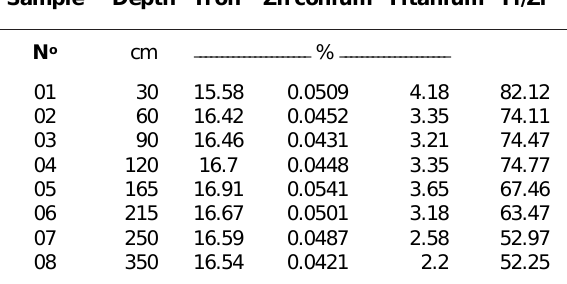
Table 2. Fe, Zr, Ti, and Ti/Zr value relations of samples taken from a pit (T3) on the limit between the summit and shoulder segments